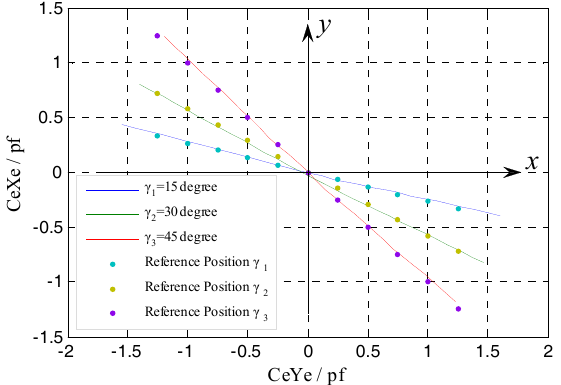
Figure 30. The comprehensive comparison of the curves of CeXe/CeYe under the different yaw angles.